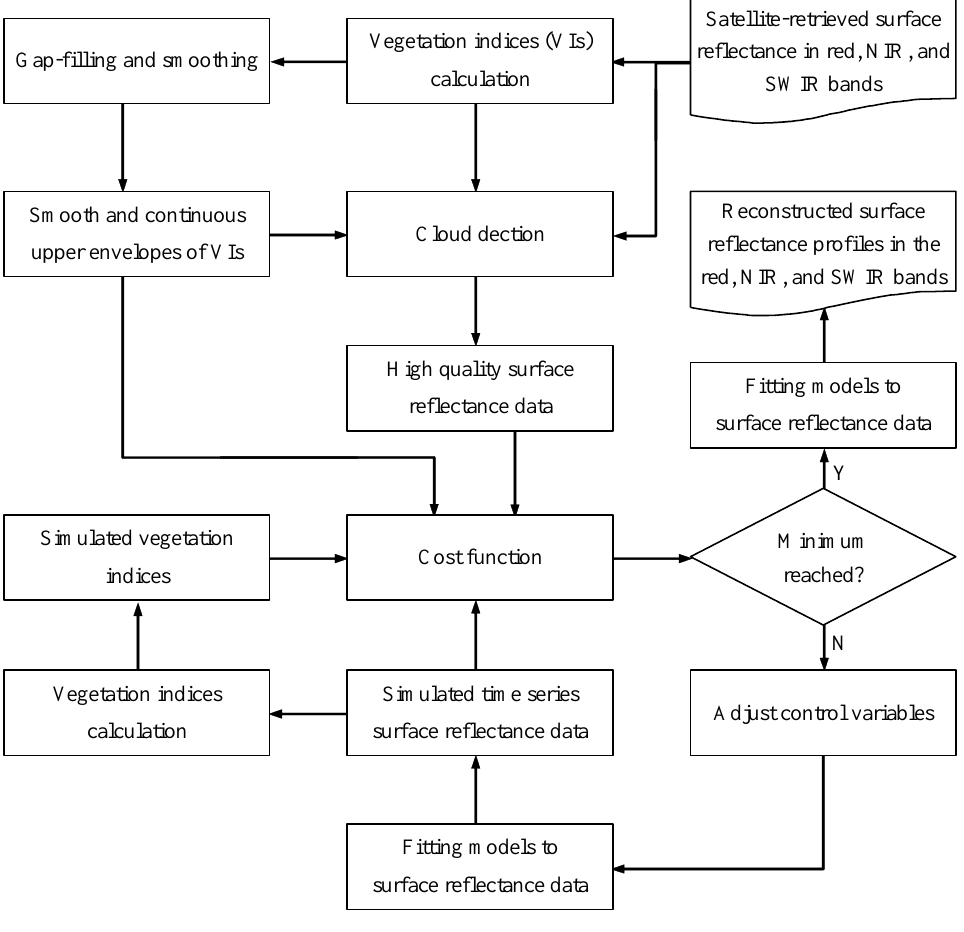
Figure 1. Flow diagram of reconstructing time series of satellite retrieved surface reflectance